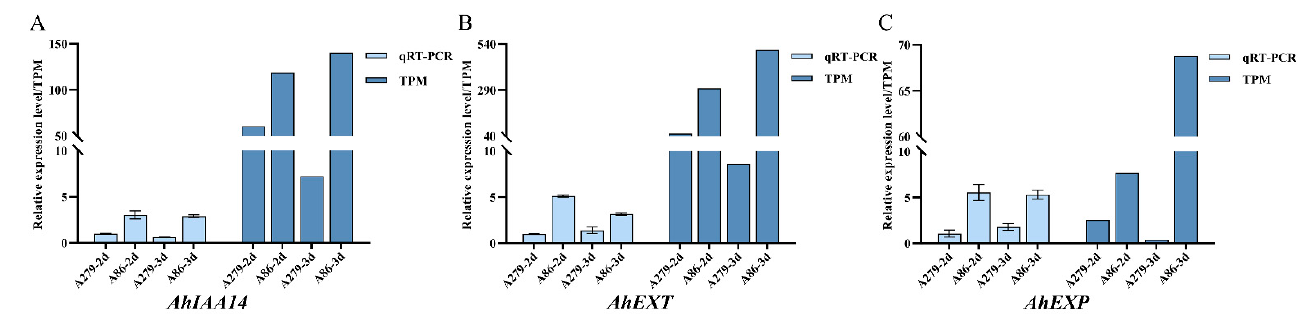
Figure 9. The qRT-PCR validations. ( A ) AhIAA14 . ( B ) AhEXT . ( C ) AhEXP . The relative expression levels of the three DEGs were calibrated against those of the Actin gene quantified by qRT ‐ PCR.